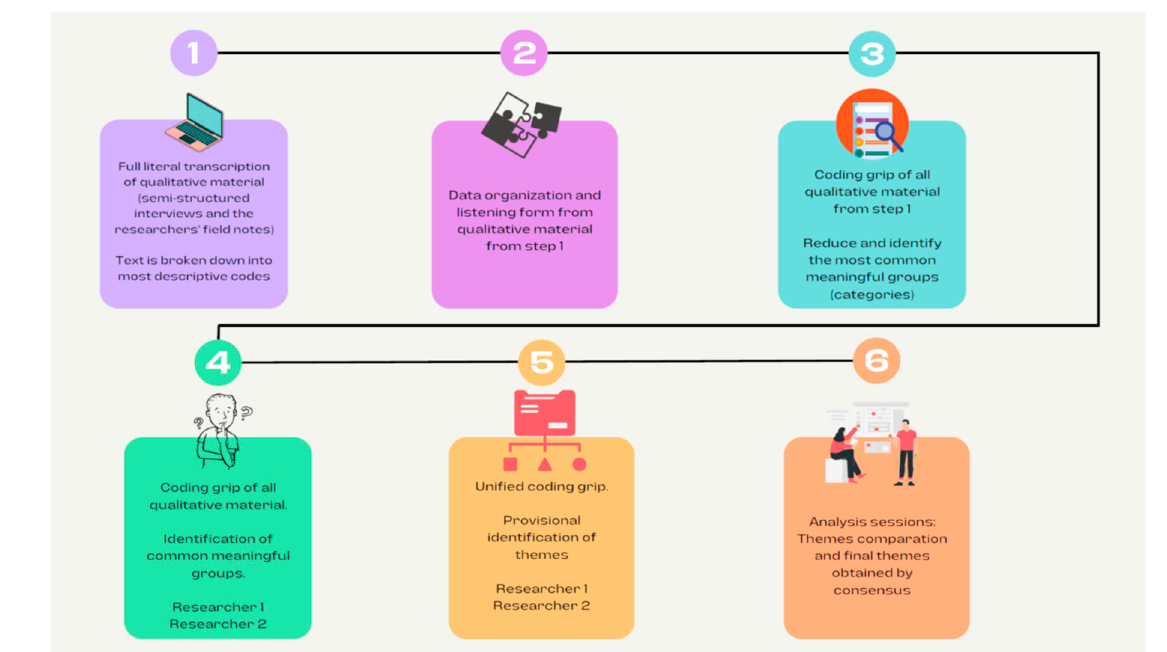
Figure 1. Integration and analysis process of qualitative materials.